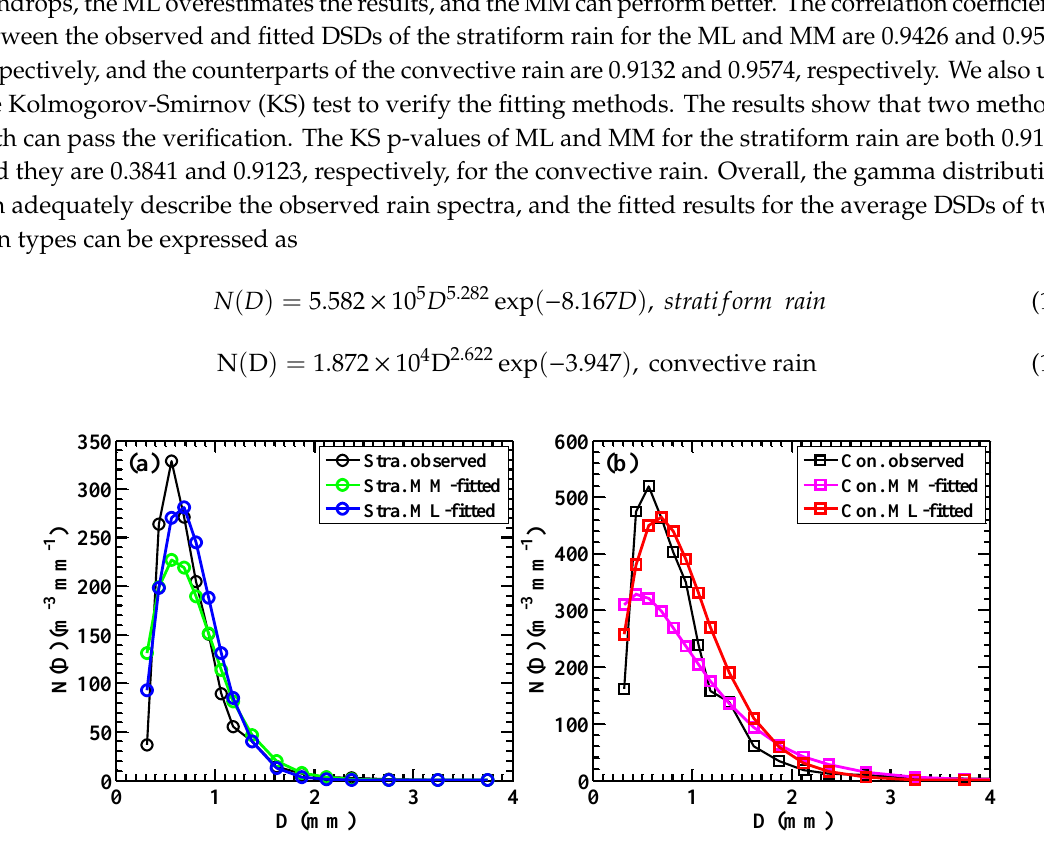
Figure 8. Average DSDs for the stratiform ( a ) and convective ( b ) rains, and fitted results using the maximum likelihood method (ML) and moment method (MM). Table 3. Integral rainfall physical quantities and gamma parameters derived from the averaged DSDs for the stratiform and convective rains, using the maximum likelihood method.